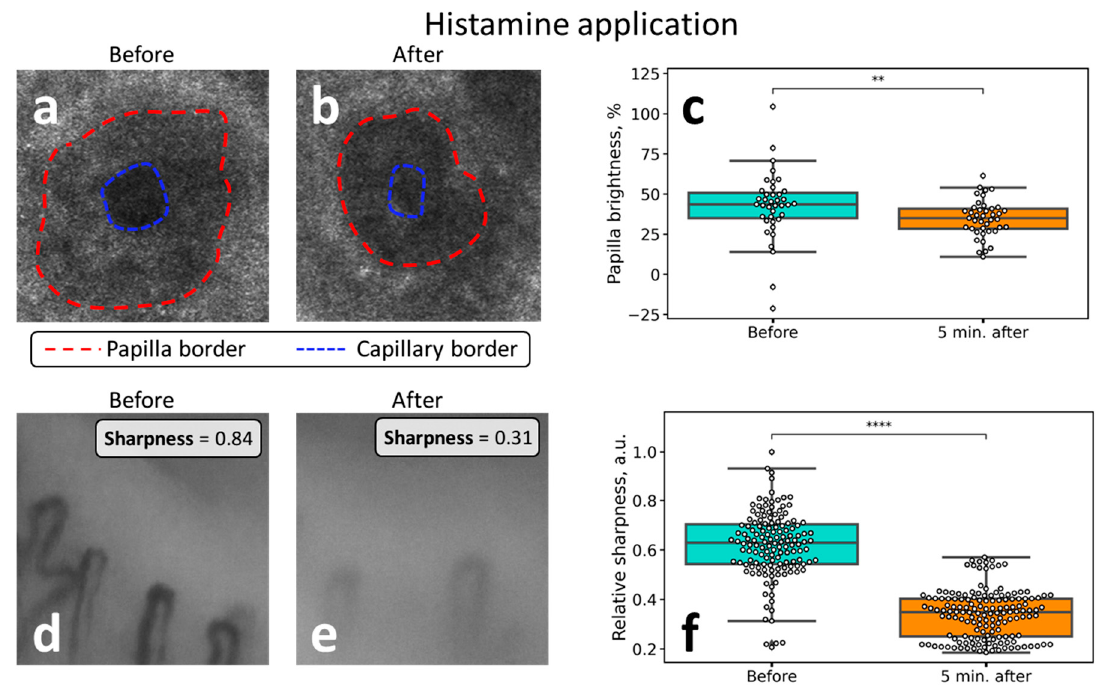
Figure 5. The images of the human forearm dermal papilla obtained with CLSM ( a ) before and ( b ) after histamine application to the skin. ( c ) The relative brightness of the dermal papillae in the CLSM images obtained before and after histamine application—the papillae become hyporefractive after treatment. The images of the human nailfold capillaries were obtained with the NVC ( d ) before and ( e ) after histamine application. ( f ) Changes of the relative sharpness (contrast) of the capillaries before and 5 min after histamine application. A significant decrease in visibility can be observed after treatment. The statistical significance was estimated using Kruskal–Wallis test with Bonferroni correction (* p < 0.05; ** p < 0.01; *** p < 0.001; **** p < 0.0001, ns—not significant).